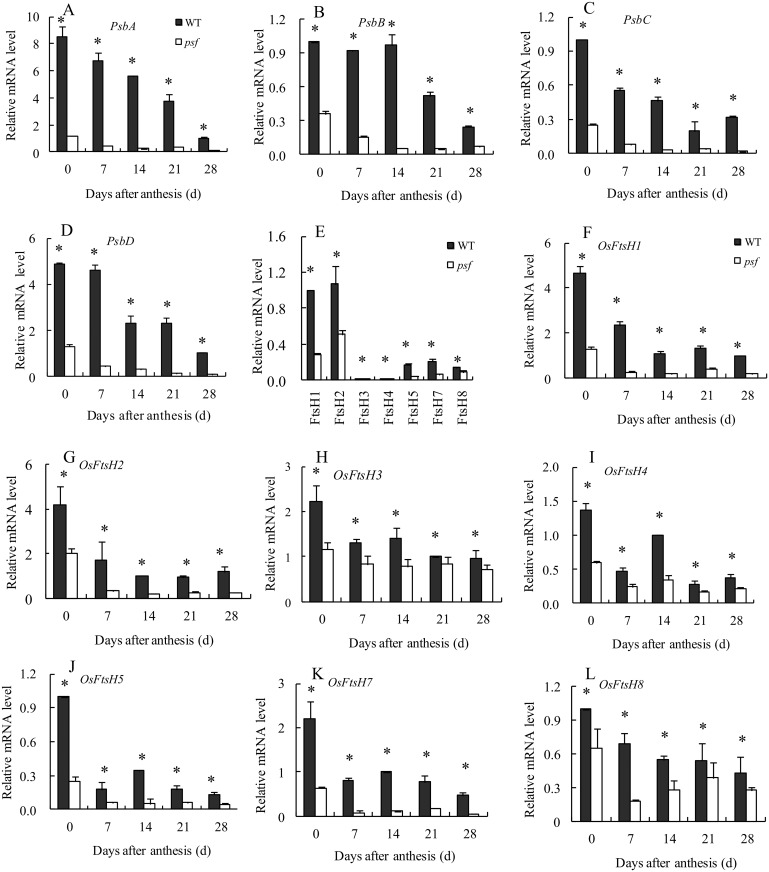
Genotypic difference in the mRNA transcript levels of several key genes involved in D1 protein turnover and their temporal patterns in the flag leaves of wild type and psf mutant after anthesis.(A) PsbA, (B) PsbB, (C) PsbC, (D) PsbD, (E) Comparison of seven FtsH isoform genes expressions at 0 day after anthesis. (F) OsFtsH1, (G) OsFtsH2, (H) OsFtsH3, (I) OsFtsH4, (J) OsFtsH5, (K) OsFtsH7, (L) OsFtsH8. Vertical bars represent standard deviation (n = 3). * indicates significant difference (P < 0.05).